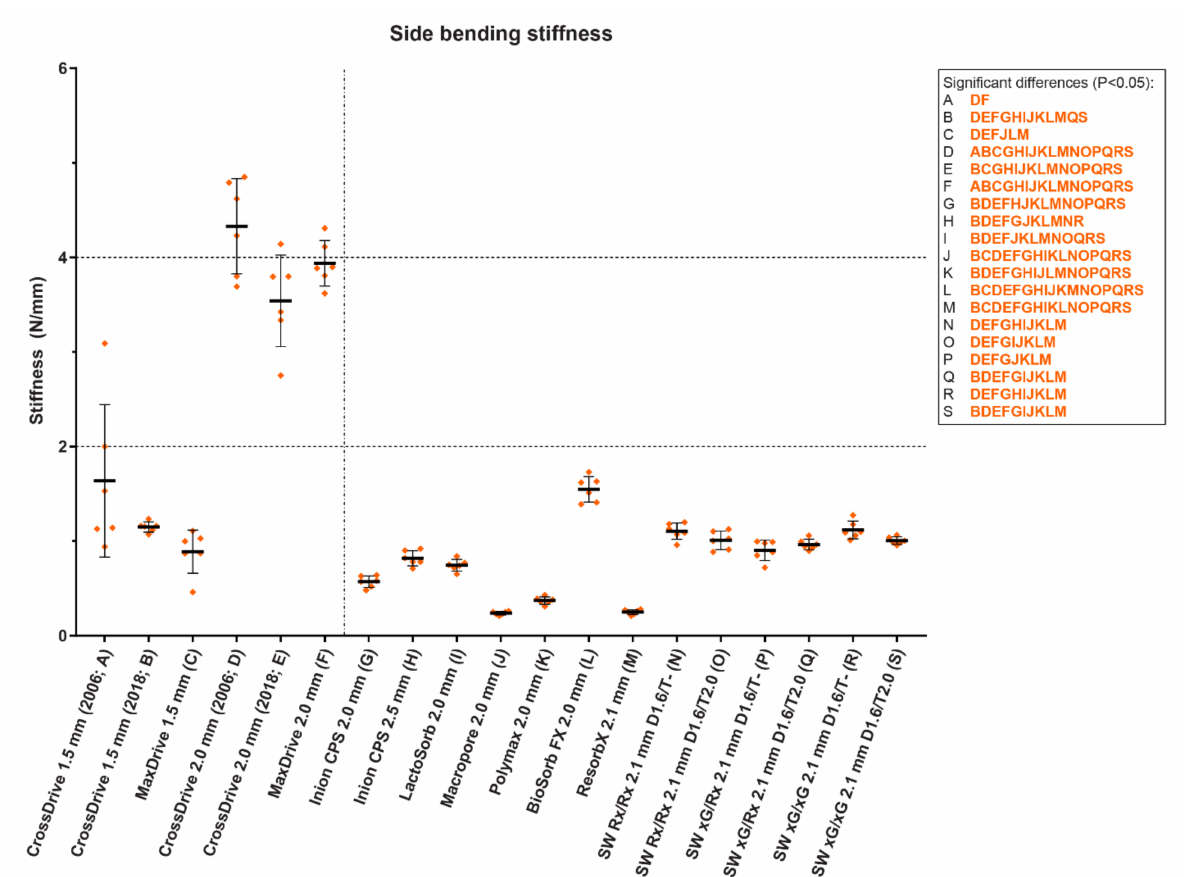
Figure 8. The side bending stiffness of 13 biodegradable and 6 titanium osteosynthesis systems commonly used in oral and maxillofacial surgery. The characters in blue and orange represent signifi- cant pairwise differences in maximum load and stiffness, respectively, between the corresponding systems using a one-way analysis of variance adjusted for multiple testing. The titanium CrossDrive (2006) plates consisted of 100% titanium produced by stamping of plates. The titanium CrossDrive (2018) and MaxDrive consisted of 100% titanium produced by milling of plates. The titanium Cross- Drive (2006 and 2018) and MaxDrive screws consisted of a Ti6Al4V alloy. The composition of each biodegradable system is described in Table 1. Error bars: mean values ± standard deviation. Ti6Al4V, 90% titanium, 6% aluminum and 4% vanadium alloy; SW, SonicWeld; D, drill diameter (mm); T, tap diameter (mm). The dotted line separates the titanium (left) and biodegradable systems (right). Reprinted with permission from